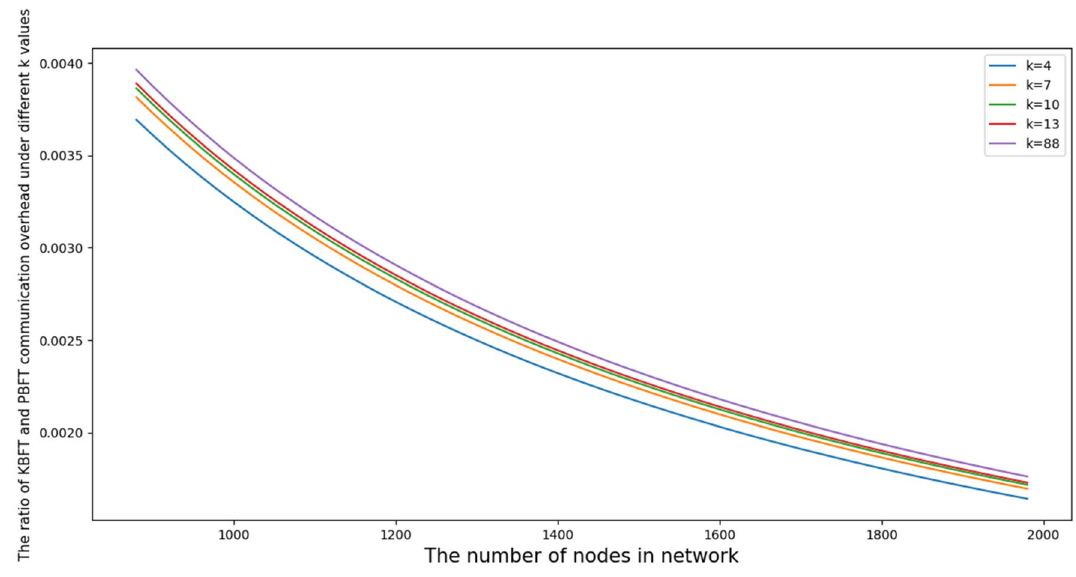
Figure 9. 2D graph of the ratio of